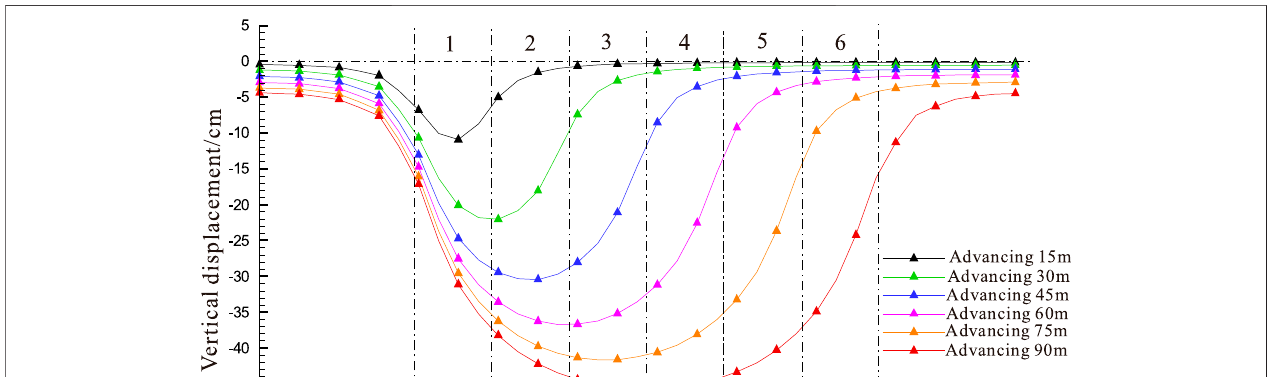
vertical and horizontal displacements of the roof. Figure 9 the centerline of the gob. Mining is stopped when the work face